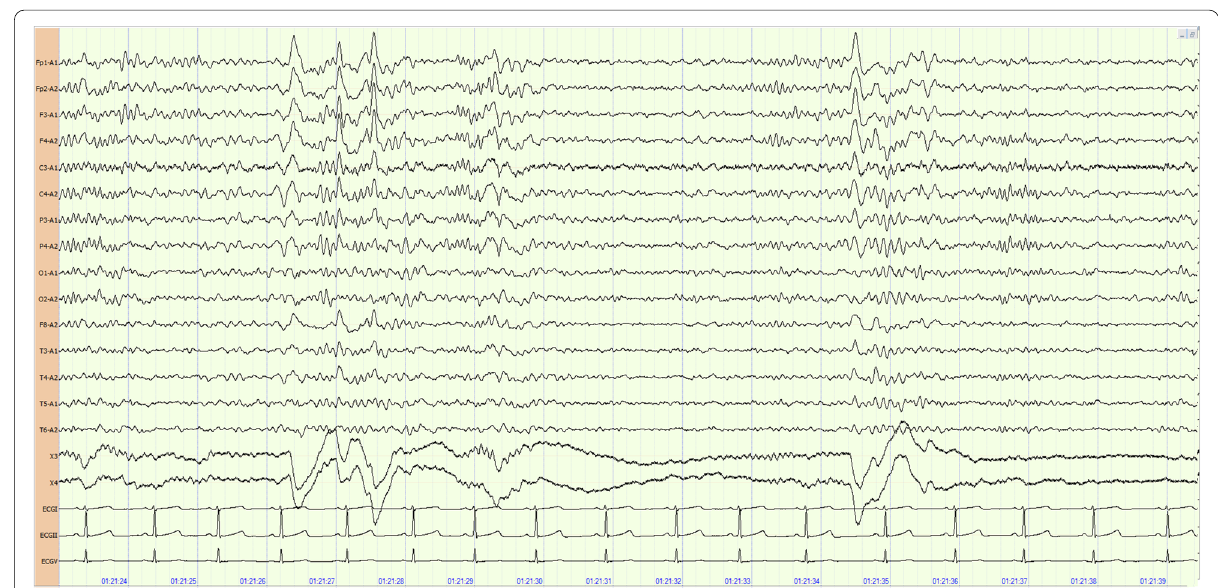
Fig. 2 EEG recording in the non-rapid eye movement (NREM) I stage. High amplitude slow waves and spikes over the former head (focused on frontal